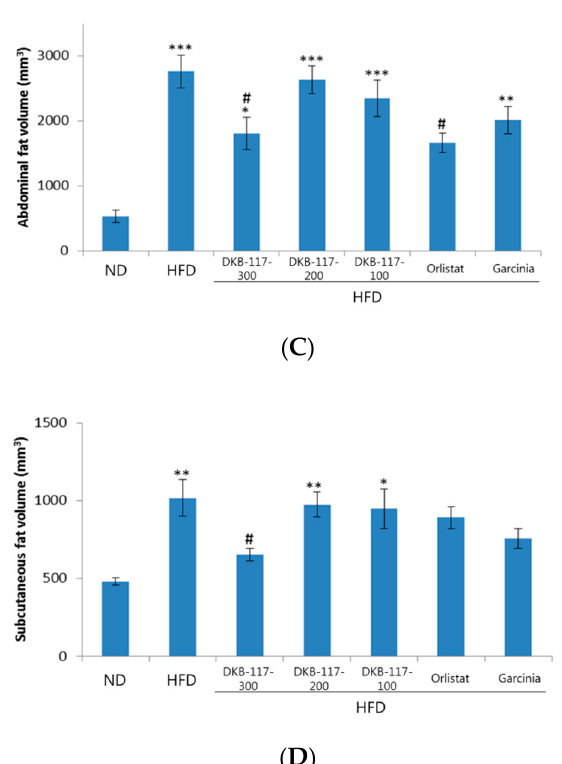
Figure 2. Effects of DKB-117 extracts on fat volume in HFD-induced obese mice. C57BL/6J mice consumed a HFD or ND for eight weeks. ( A ) Transverse microcomputed tomography (micro-CT) images. ( B ) Total fat volume, ( C ) abdominal fat volume, and ( D ) subcutaneous fat volume were measured using micro-CT. The values are presented as means ± SEMs. ***/**/* A significant difference at the p < 0.001/ p < 0.01/ p < 0.05 level was observed versus the ND. # A significant difference at the p < 0.05 level was observed versus the HFD. ND, normal diet control group; HFD, high-fat diet control group; DKB-117-300, DKB-117 300 mg/kg; DKB-117-200, DKB-117 200 mg/kg; DKB-117-100, DKB-117 100 mg/kg; Orlistat, orlistat 40 mg/kg; Garcinia, Garcinia cambogia 200 mg/kg.